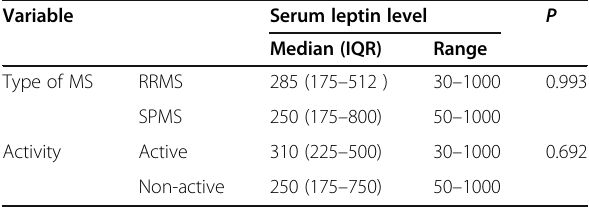
Table 3 Comparison of serum leptin level regarding the type of MS and activity of disease Variable